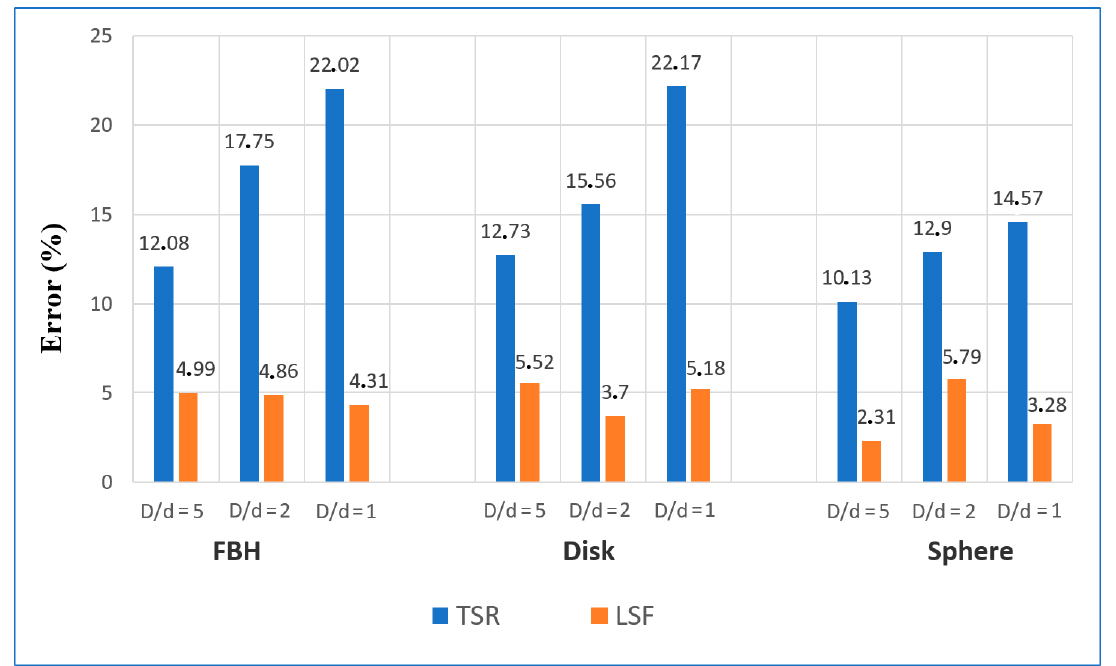
Figure 8. Mean relative errors of depth estimation by using TSR and NLF techniques (theory).